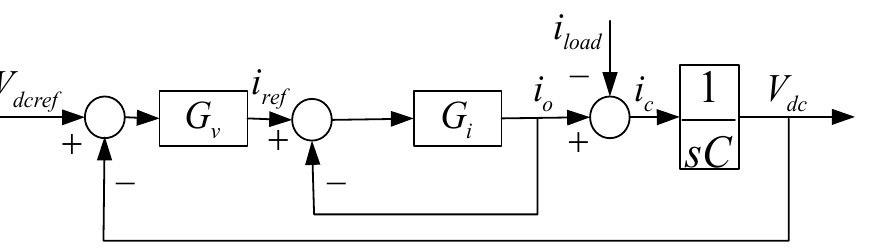
Figure 10. Double closed-loop control block diagram of AC/DC converter.